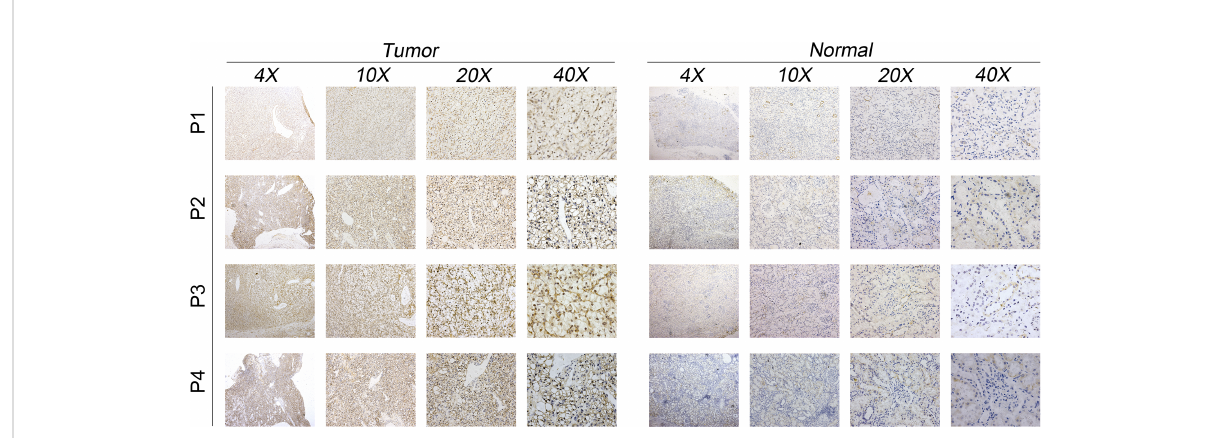
FIGURE 7 IHC result of MYBL1 between ccRCC tumor and control